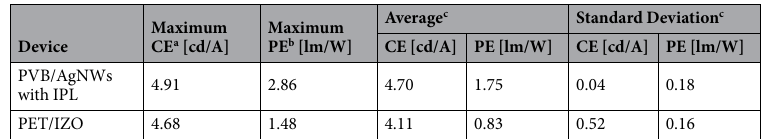
Maximum CE a [cd/A]